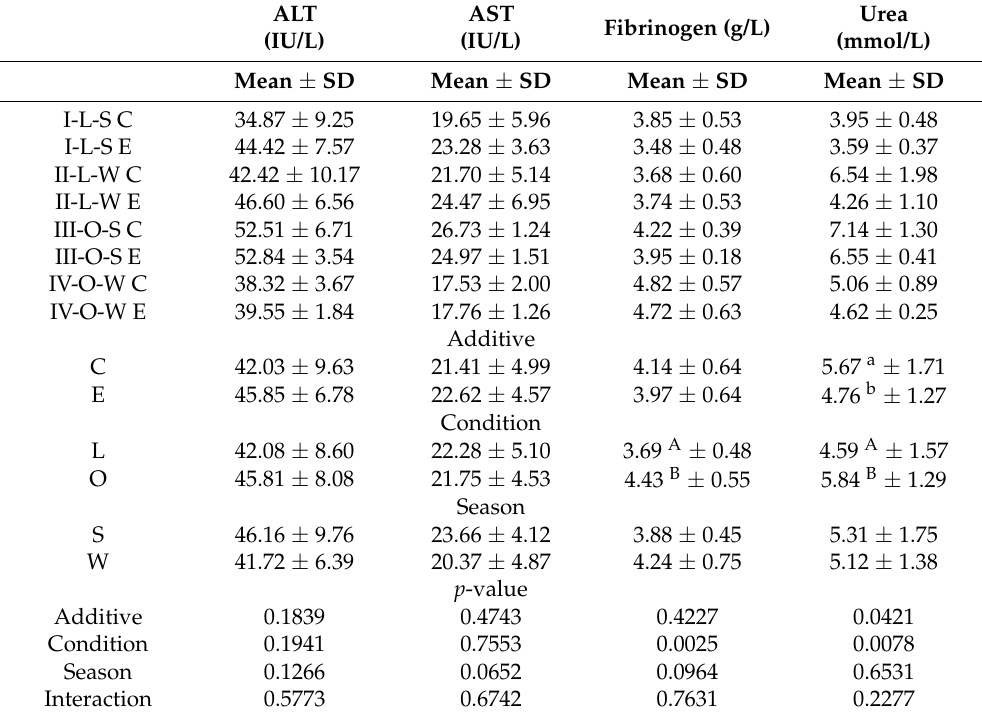
Table 5. Biochemical parameters of the blood of termond white